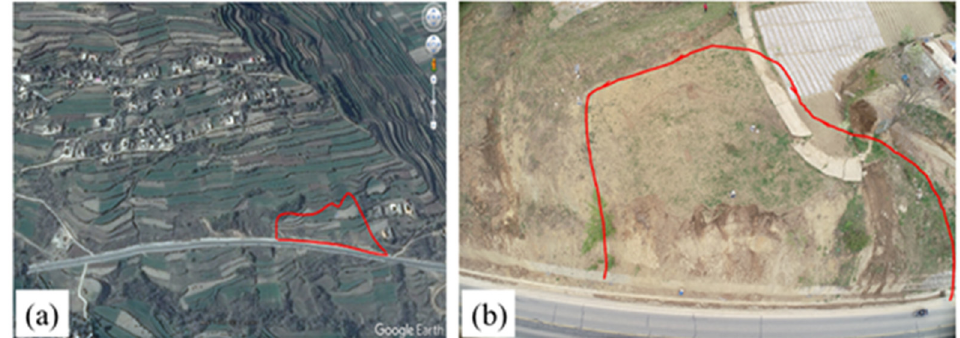
Figure 6. ( a ) Optical remote sensing imagery of Lashagou NO. 3 landslide acquired from Google Earth; ( b ) UAV image of Lashagou NO. 3 landslide.